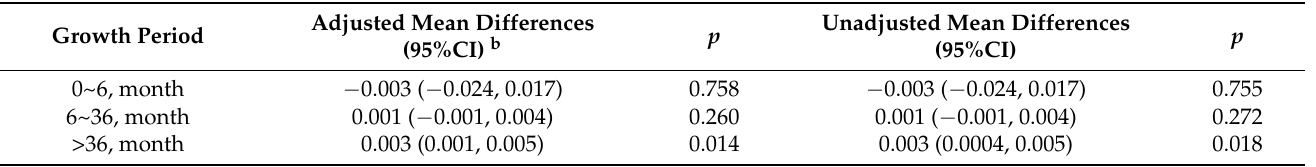
Table 2. Mean differences in zBMI growth rates (SD units per month) for cesarean delivery compared with vaginal delivery (reference) during each growth period a